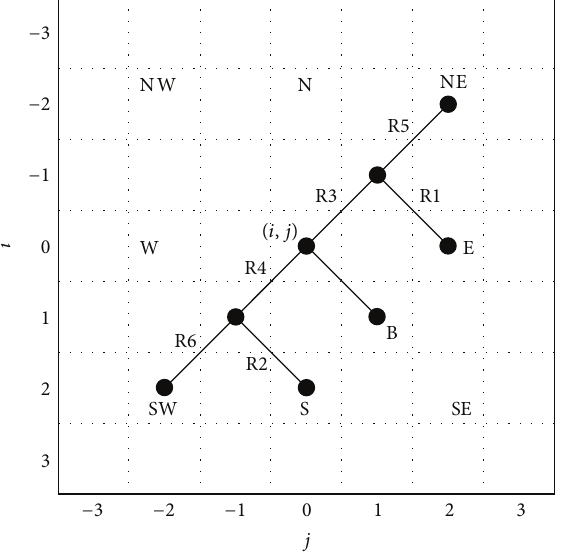
Figure 2: Six related and basic